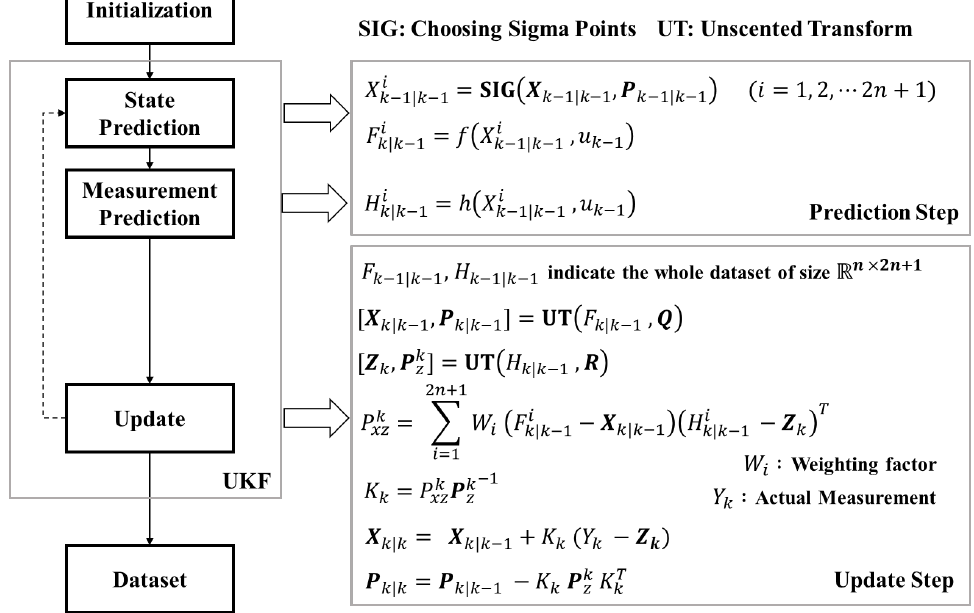
Figure 5. Simplified framework of UKF